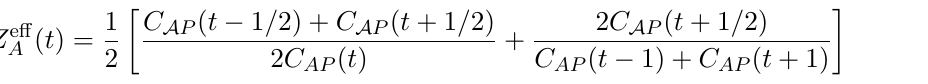
Figure 4 . Collected data for the ratio of decay constants f D (cid:12)ts. The solid vertical line labelled \phys" corresponds to the physical (cid:17) c mass. renormalised axial currents using appropriate ratios of o(cid:11)-shell mixed and unmixed action vertex